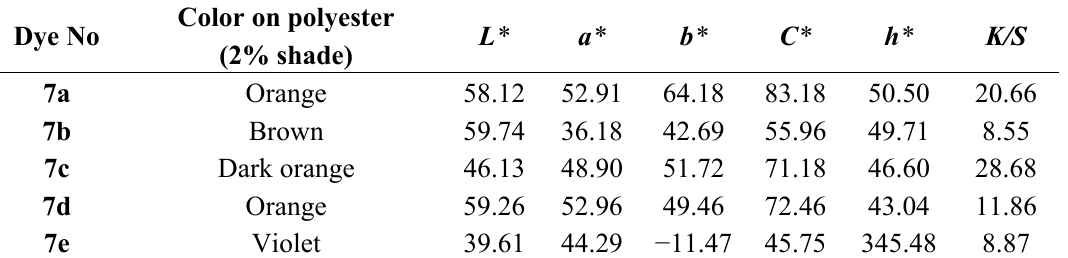
Table 1. Shade and optical measurements of the azo disperse dyes on the polyester fabrics. Dye